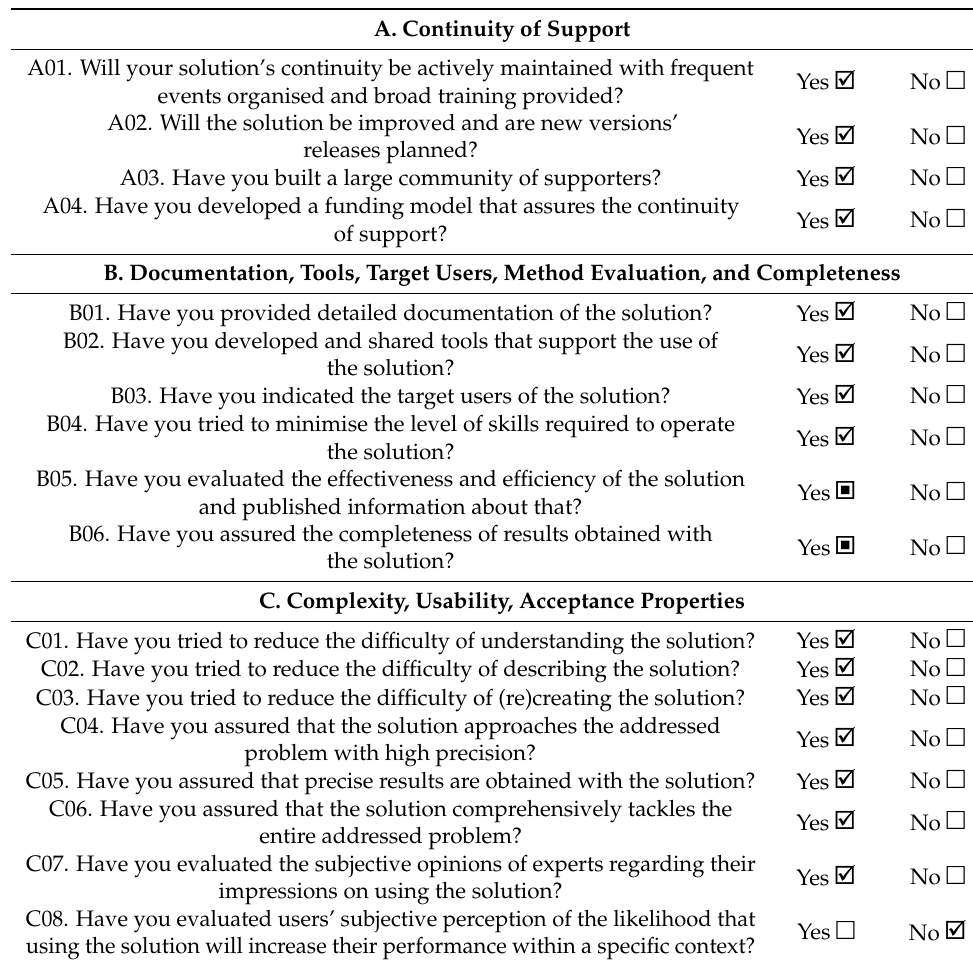
Table 1. Applicability control list. The symbol depicts a completely addressed control question. indicates an area that has been partially covered.